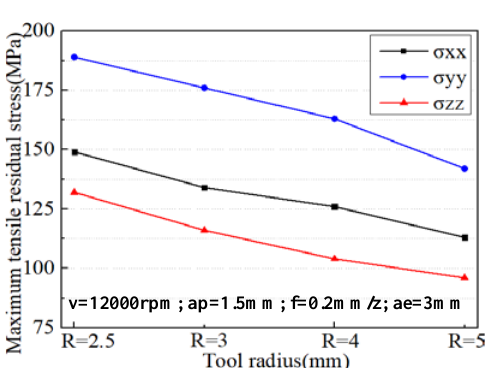
(c) The effects of feed per tooth on residual stress